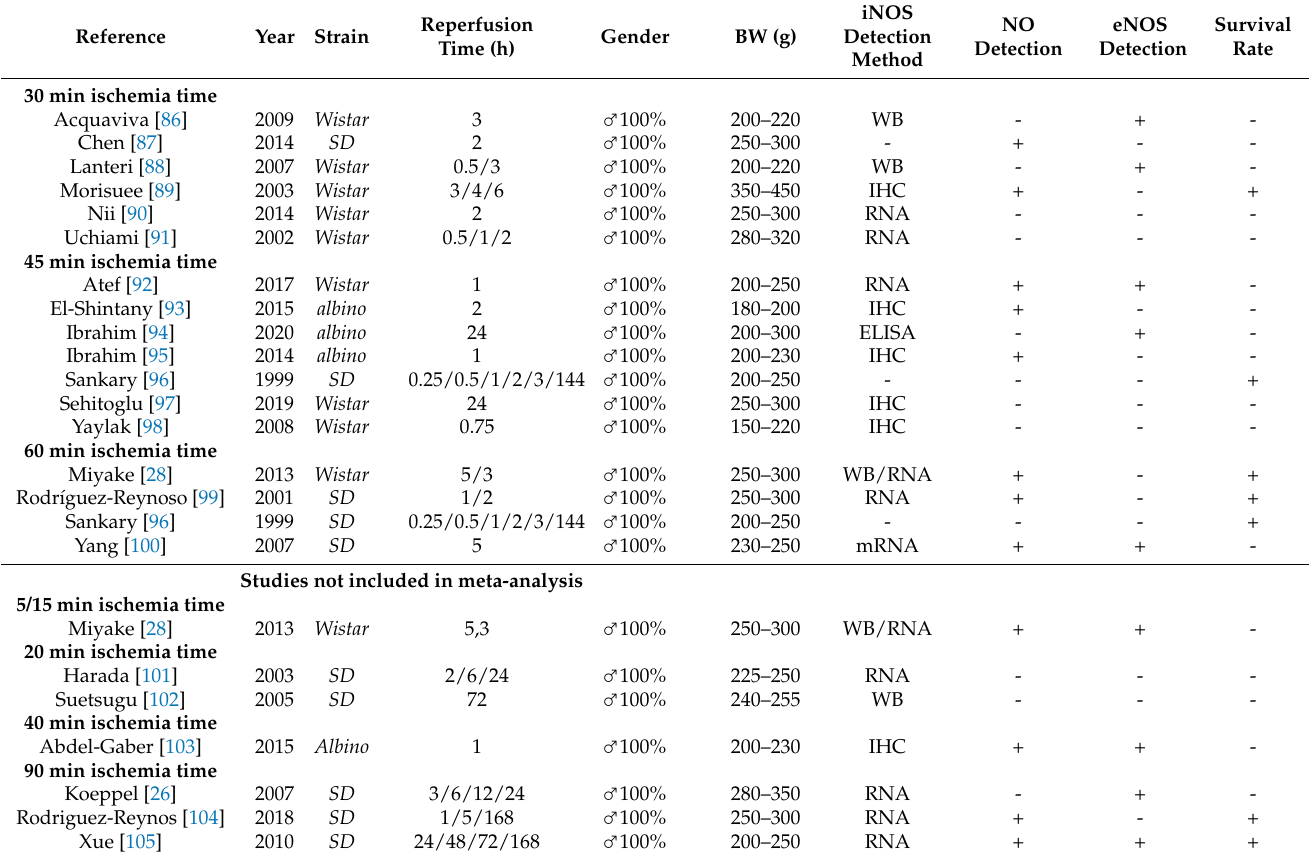
Table 2. Overview of rat models with 100% HIRI.